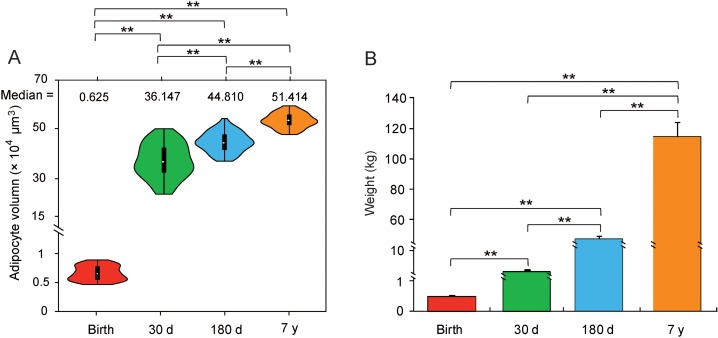
Differences in phenotype.(A) Violin plot of adipocyte volume. Each “violin” with the width depicting a 90°-rotated kernel density trace and its reflection. Vertical black boxes denote the Interquartile Range (IQR) between the first and third quartiles (25th and 75th percentiles, respectively) and the white point inside denotes the median. Vertical black lines denote the lowest and highest values within 1.5 times IQR from the first and third quartiles, respectively. The statistical significance was calculated by the Mann–Whitney U test (**: P < 10−6). (B) The body weight across four stages. The significance of differences among stages was determined by Student’s t-test (**: P < 10−4).